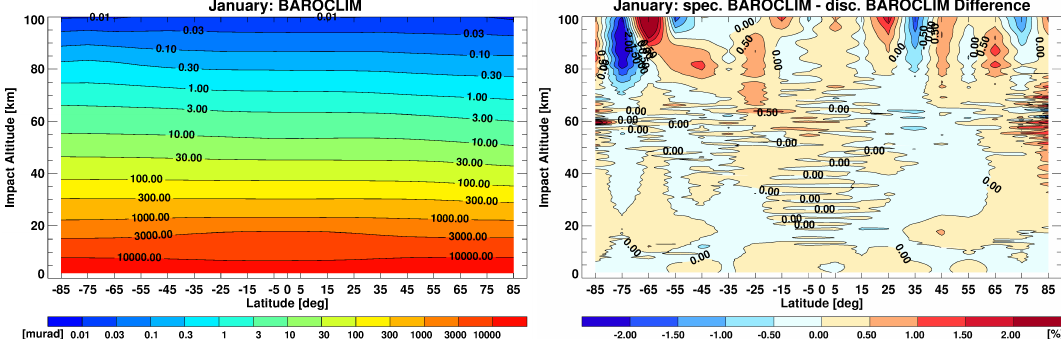
Figure 4. BAROCLIM spectral model (calculated with 128 Chebychev coefficients and 18 zonal harmonics coefficients) as a function of latitude and impact altitude for January (left) and difference between the BAROCLIM spectral model and the BAROCLIM discrete model